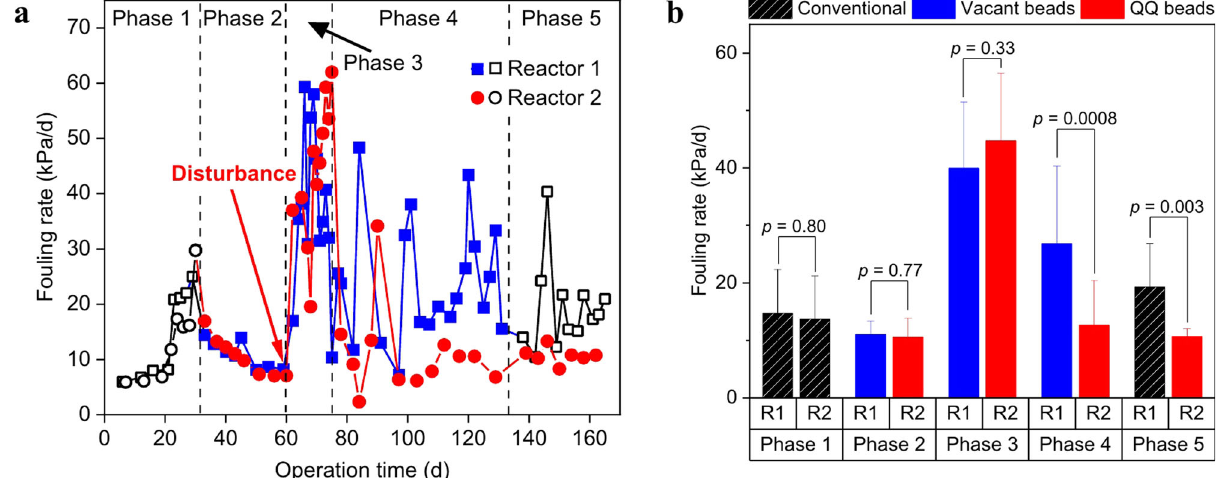
Fig. 1 Membrane-fouling rate. a Its variations with time for Reactor 1 (R1) and Reactor 2 (R2). Each data point indicates the average fouling rate for each MBR run. b Average fouling rates with t -test probability ( p ) values for each phase. Error bars indicate 1 SD. Details on the experimental conditions are provided in Table